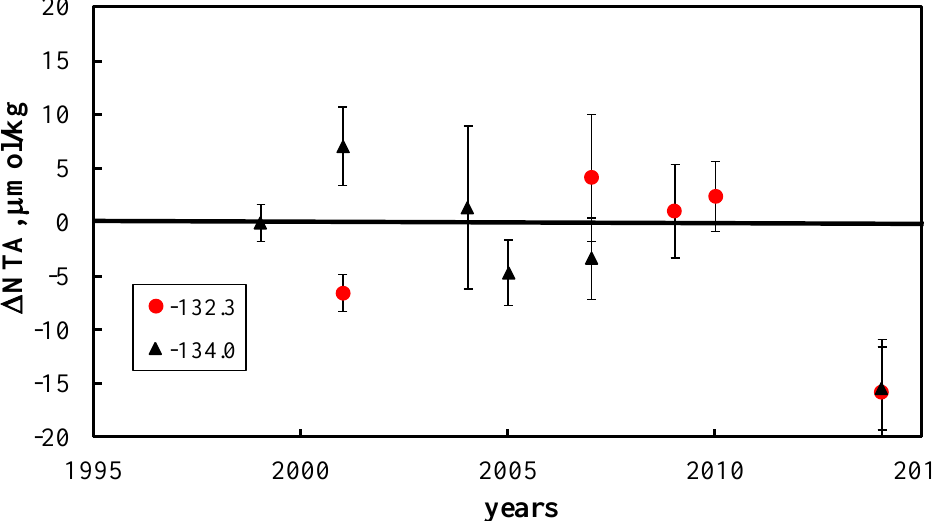
Figure 4. Averaged differences of NTA between particular cruises (given year cruises) and 1999 cruises ( ∆ NTA = NTA(year) − NTA(1999). Water samples were taken along 132°20′ E (red) and 134°00′ E (black) sections. Bars are 3·s.d. = 3·[s.d.(year + s.d.(1999)].